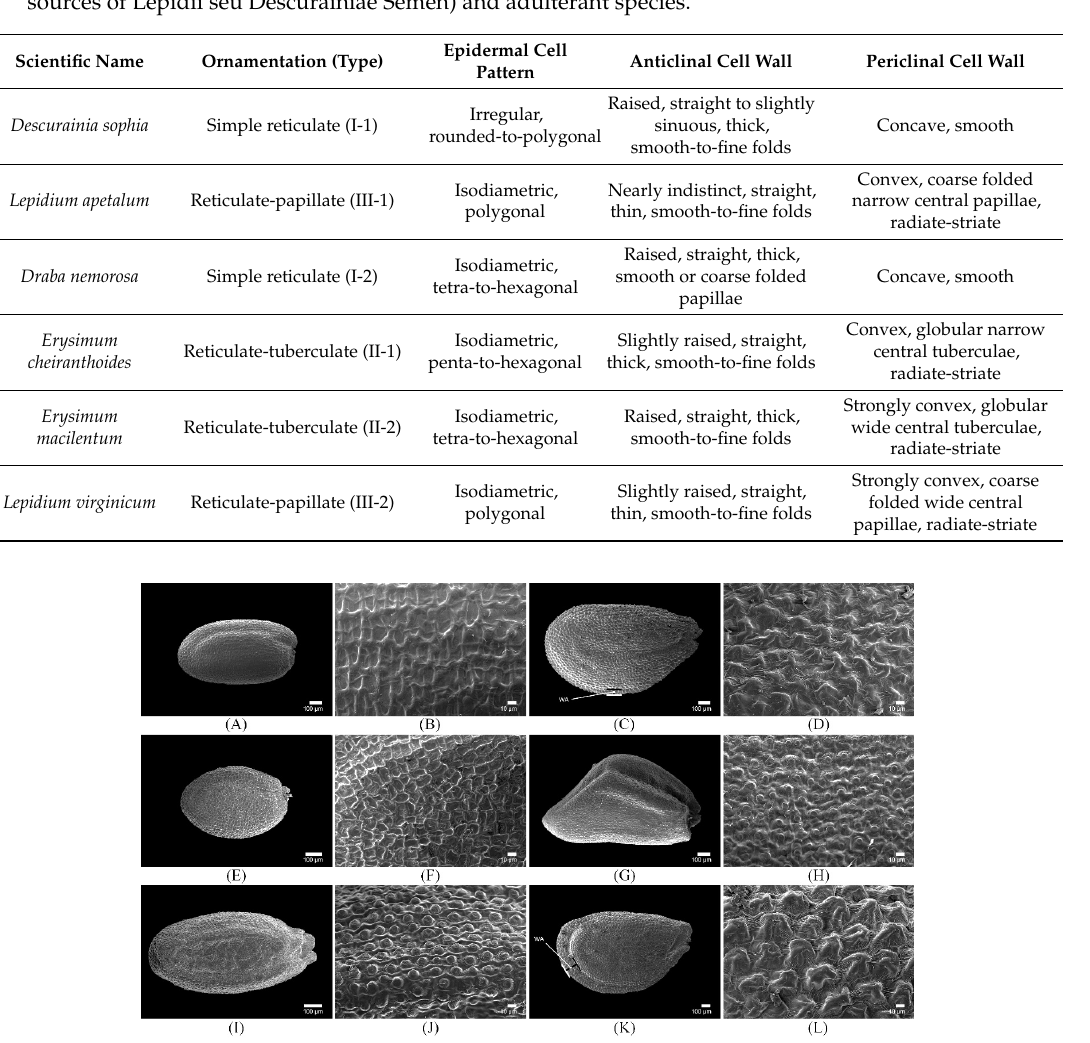
Table 3. Micromorphological characteristics of Descurainia sophia and Lepidium apetalum (authentic sources of Lepidii seu Descurainiae Semen) and adulterant species.